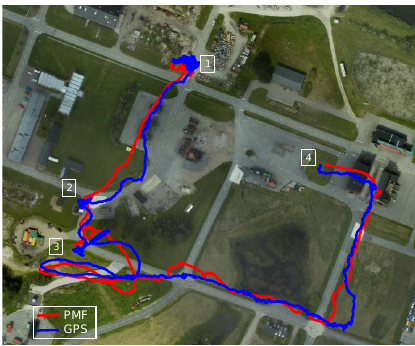
Figure 9: Real-time on-board position estimation results. Com- parison between the flight path computed with the PMF (red) and the GPS reference